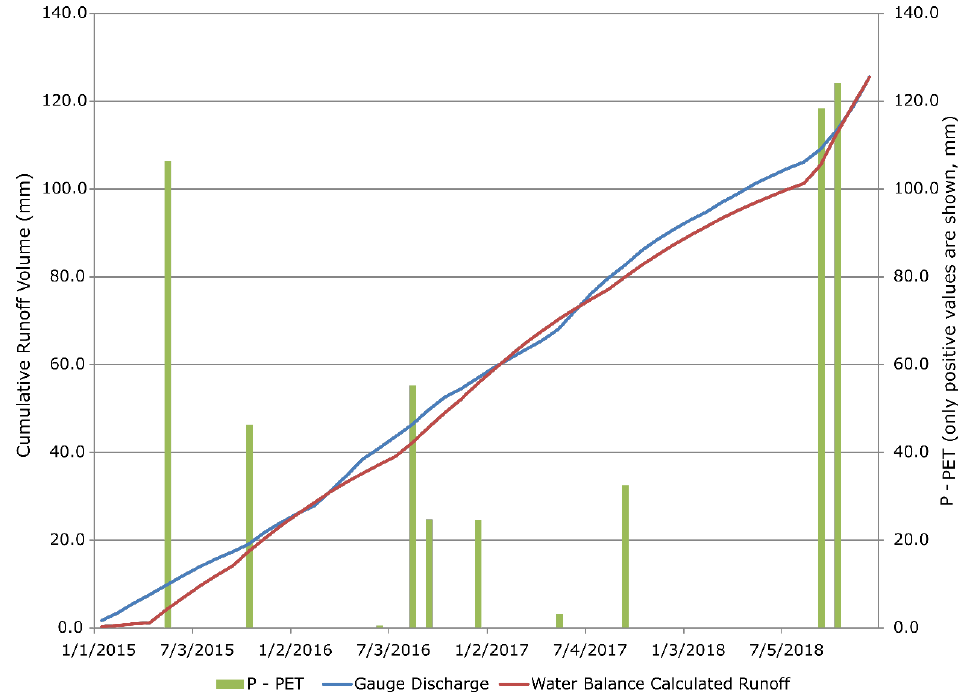
Figure A3. Monthly water balance model—calibrated match of simulated runoff to observed gauge discharge. The monthly water balance calculation approach will only provide a reasonable match of cumulative gauge discharge to water balance runoff, and runoff includes spring discharge in this simulation. It is assumed that the spring shed is within the watershed footprint and that subsurface runoff and interflow from within the watershed provides spring discharge. Also, note the limited months with positive P − PET. Table A2. Water balance calculation inputs and results.